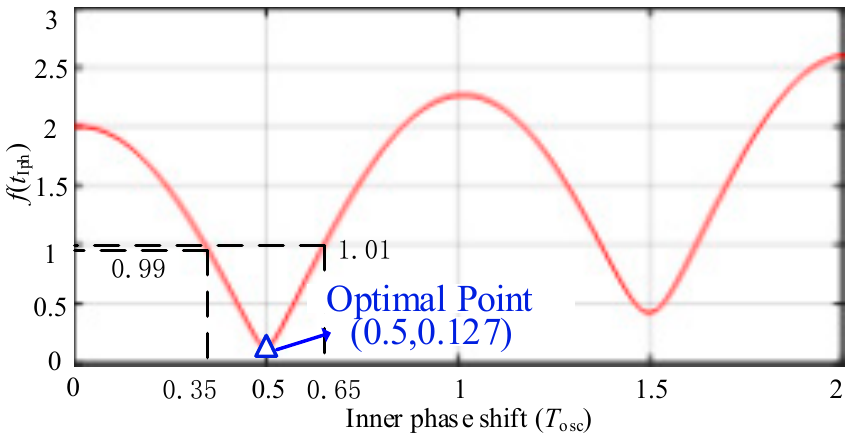
Figure 9. Oscillation amplitude vs. inner phase ‐ shift.